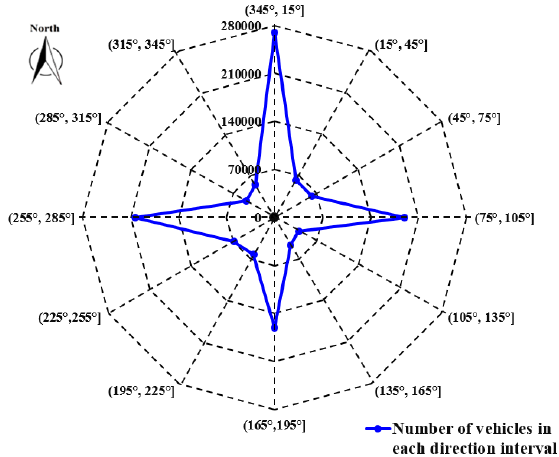
Figure 10. The statistical results of the directions in which vehicles were heading.